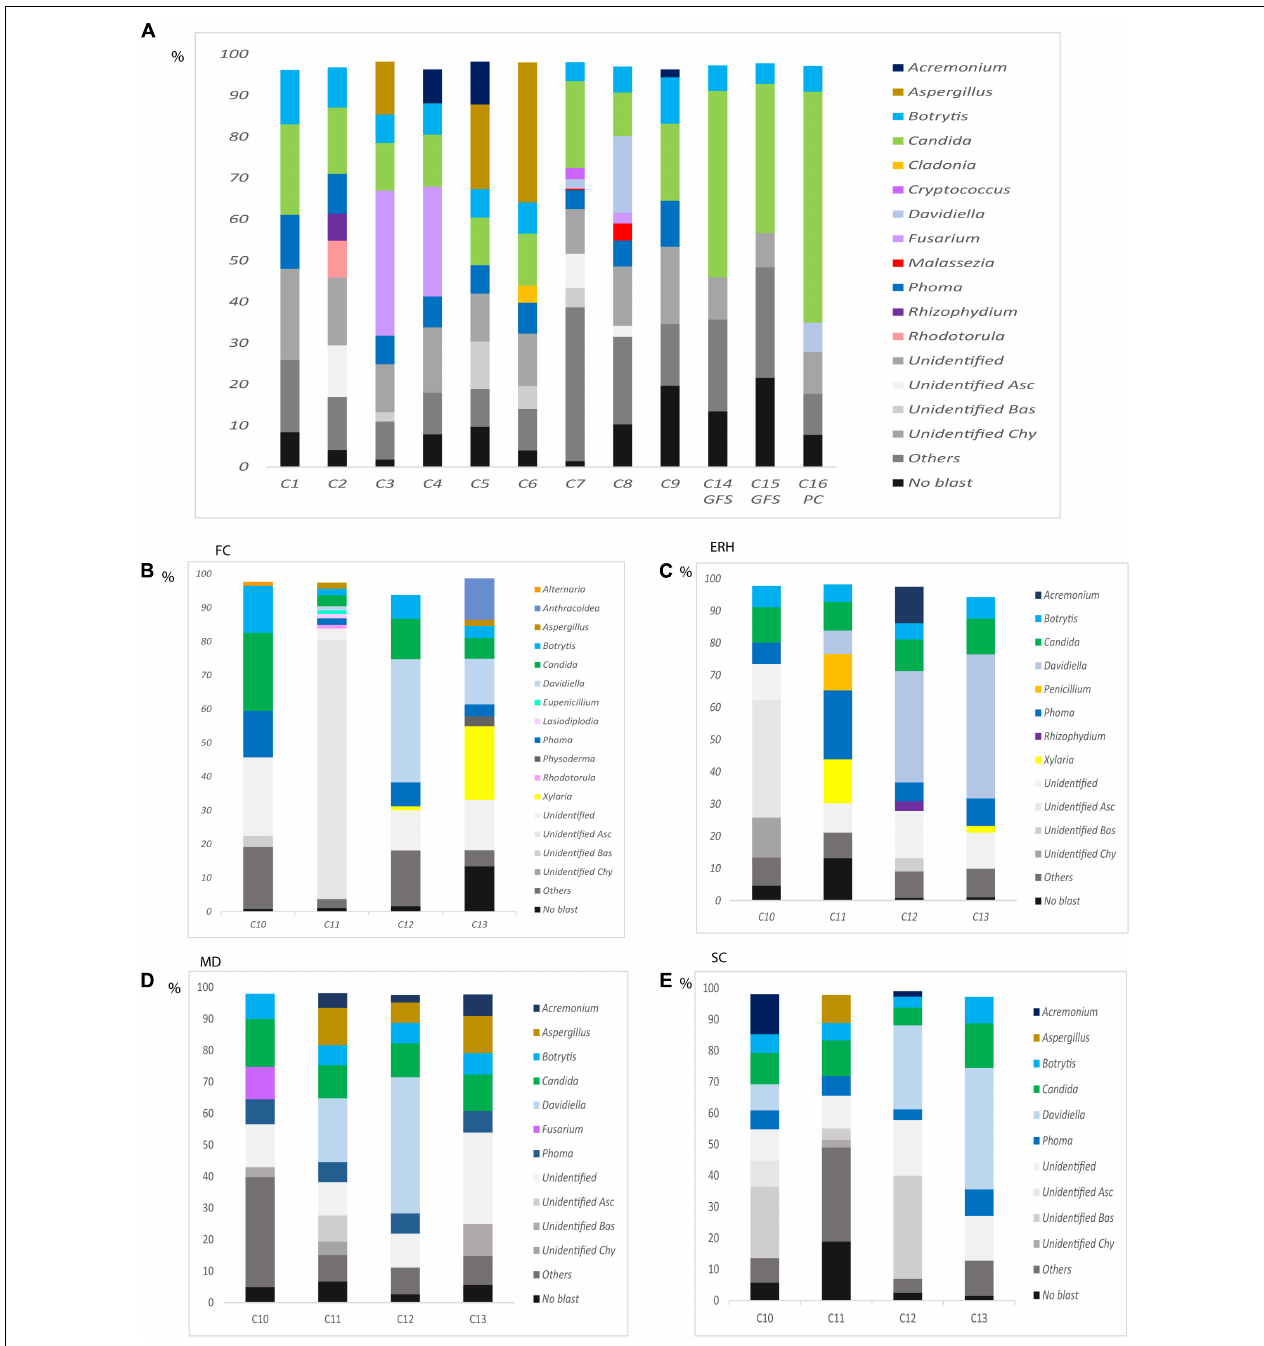
FIGURE 5 | Distribution of fungal genera obtained by NGS of DNA from control subjects. Computational analyses of the sequences obtained on the Illumina platform using Qiime classified the data into fungal genera. Results of fungal genera obtained from DNA extracted from nine samples of frozen ERH tissue of controls (C1–C9) and two Superior Frontal Gire controls (C14, C15) and one Parietal cortex control (C16) (A) Results of fungal genera obtained from four CNS regions: FC, ERH, MD, and SC from four controls (B–E) . Asc, Ascomycota ; Bas, Basidiomycota ; Chy , Chytridiomycota